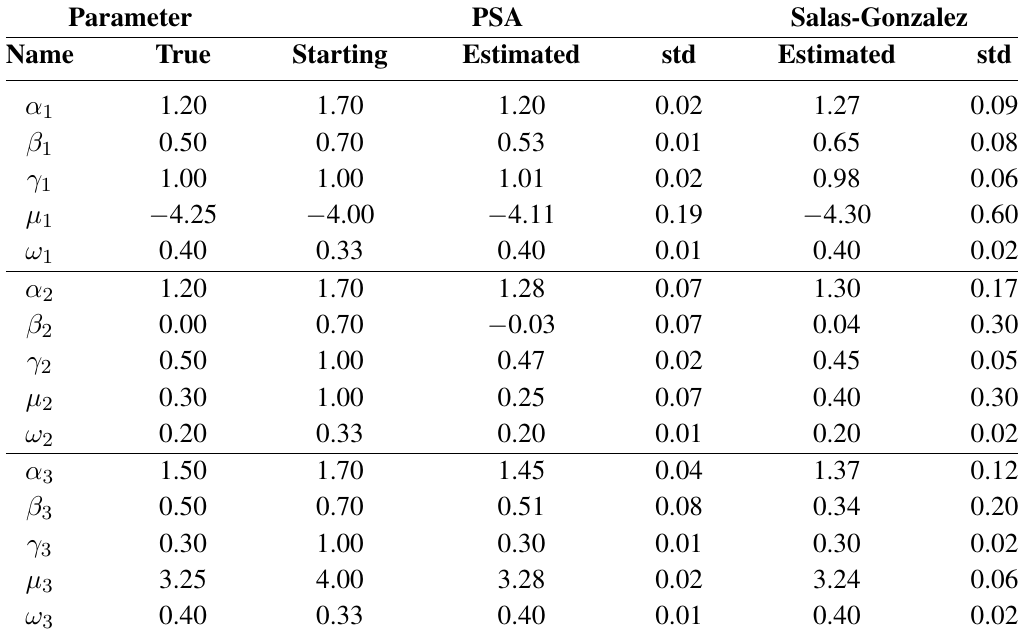
Table 1. Simulation results for the PSA estimator on MAS distributions. Parameter PSA